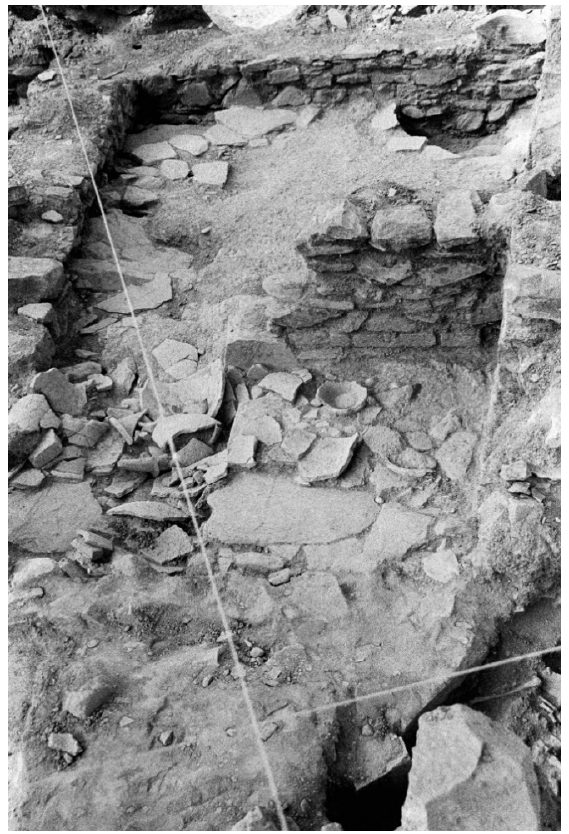
Figure 10. Mértola—house n. 2 (kitchen). Photo took by author.